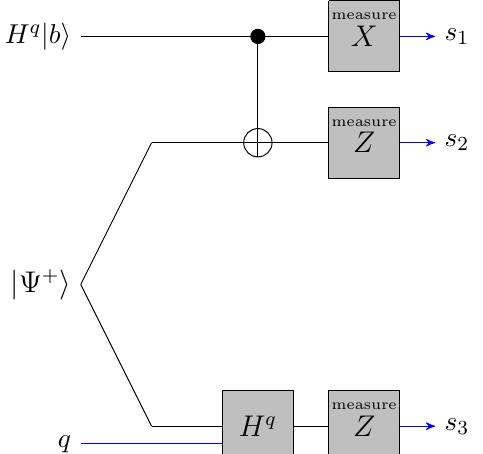
Figure 11. Circuit diagram for the teleportation based protocol that completes the B 84 task. Blue lines indicate classical inputs and outputs. The protocol uses one EPR pair, j (cid:9) + i = 1 p b is a function of the classical measurement outcomes according to ( (cid:0) 1) b = s q is not the protocol employed by AdS/CFT, it illustrates how access to the central region P can be replaced with use of